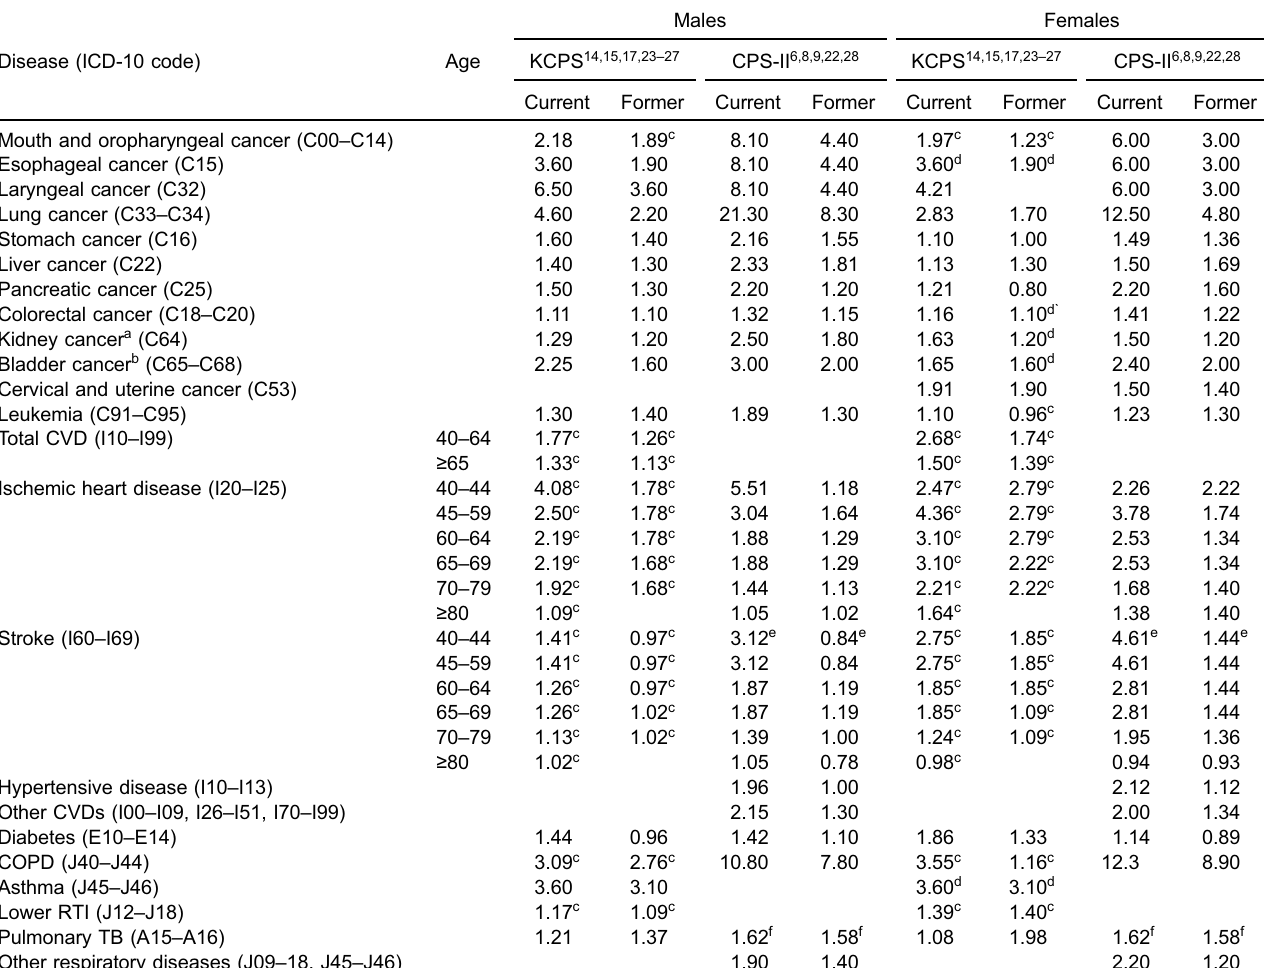
Table 1. Relative risks for diseases associated with tobacco smoking